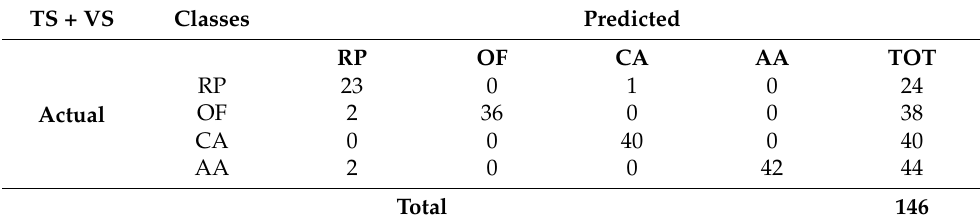
Table 6. TS + VS confusion matrix with the application of correction coefficients.